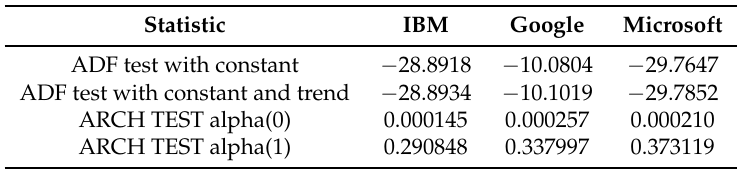
Table 2. Base series unit root and ARCH tests.